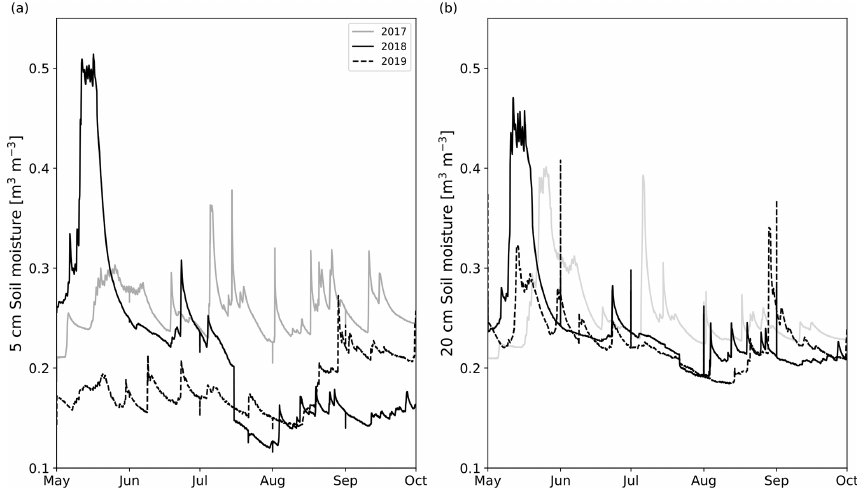
Figure 3. The daily mean (a) 5cm and (b) 20cm soil moisture time series measured from two different locations outside the experimental area from May to October in 2017 (solid gray line), 2018 (solid black line), and 2019 (dashed black